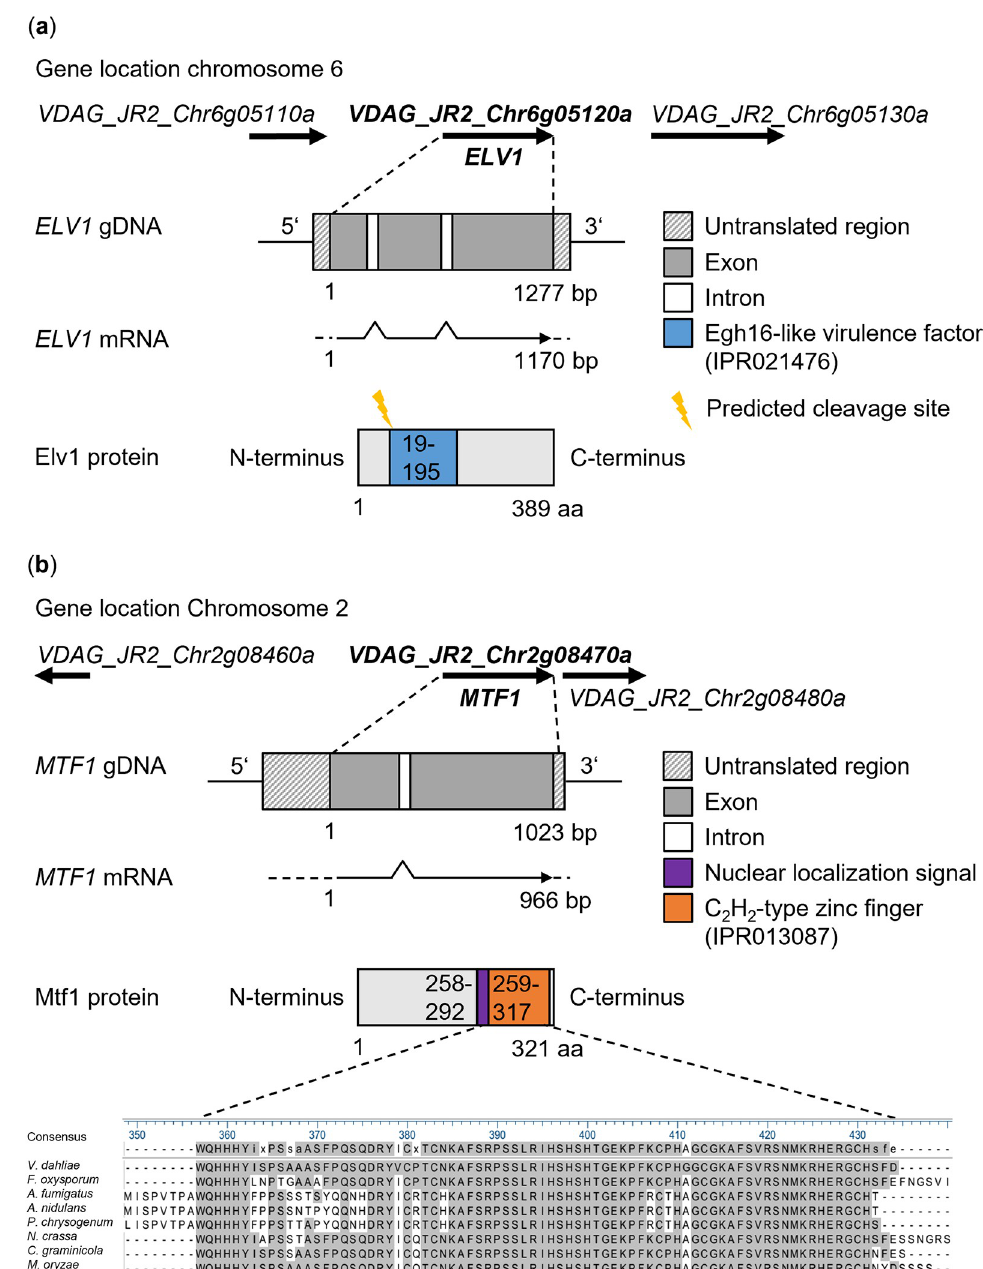
Fig 2. Genomic structure of the Egh16-like virulence factor Elv1 and the Mtf1 transcription factor-encoding genes in Verticillium dahliae . Genomic location and neighboring genes with directions of transcription are shown. Intron- exon structures were predicted by Ensembl Fungi. Predicted untranslated regions are represented by color-hatched regions. (a) ELV1 ( VDAG_JR2_Chr6g05120a ) is located on chromosome six. The 1277 base pair (bp) ELV1 open reading frame includes three exons (in gray) and two introns (in white). The Elv1 protein consists of 389 amino acids (aa) and contains the Egh16-like virulence factor domain (IPR021476; 19–195 aa; in blue) predicted by InterPro. A signal peptide was predicted with a cleavage site between amino acid residues 19 and 20 (probability 0.97; in yellow) using SignalP 6.0. (b) MTF1 ( VDAG_JR2_Chr2g08470a ) is located on chromosome two. The 1023 bp V . dahliae MTF1 open reading frame harbors two exons (in gray) and one intron (in white). The Mtf1 protein consists of 321 aa. It contains a putative nuclear localization signal (258–292 aa; in purple) predicted by cNLS Mapper and a highly conserved C 2 H 2 -type zinc finger domain (IPR013087; 259–317 aa; in orange) predicted by InterPro. An amino acid sequence alignment of the conserved region in different ascomycetes is shown. Similar amino acids are highlighted in gray.